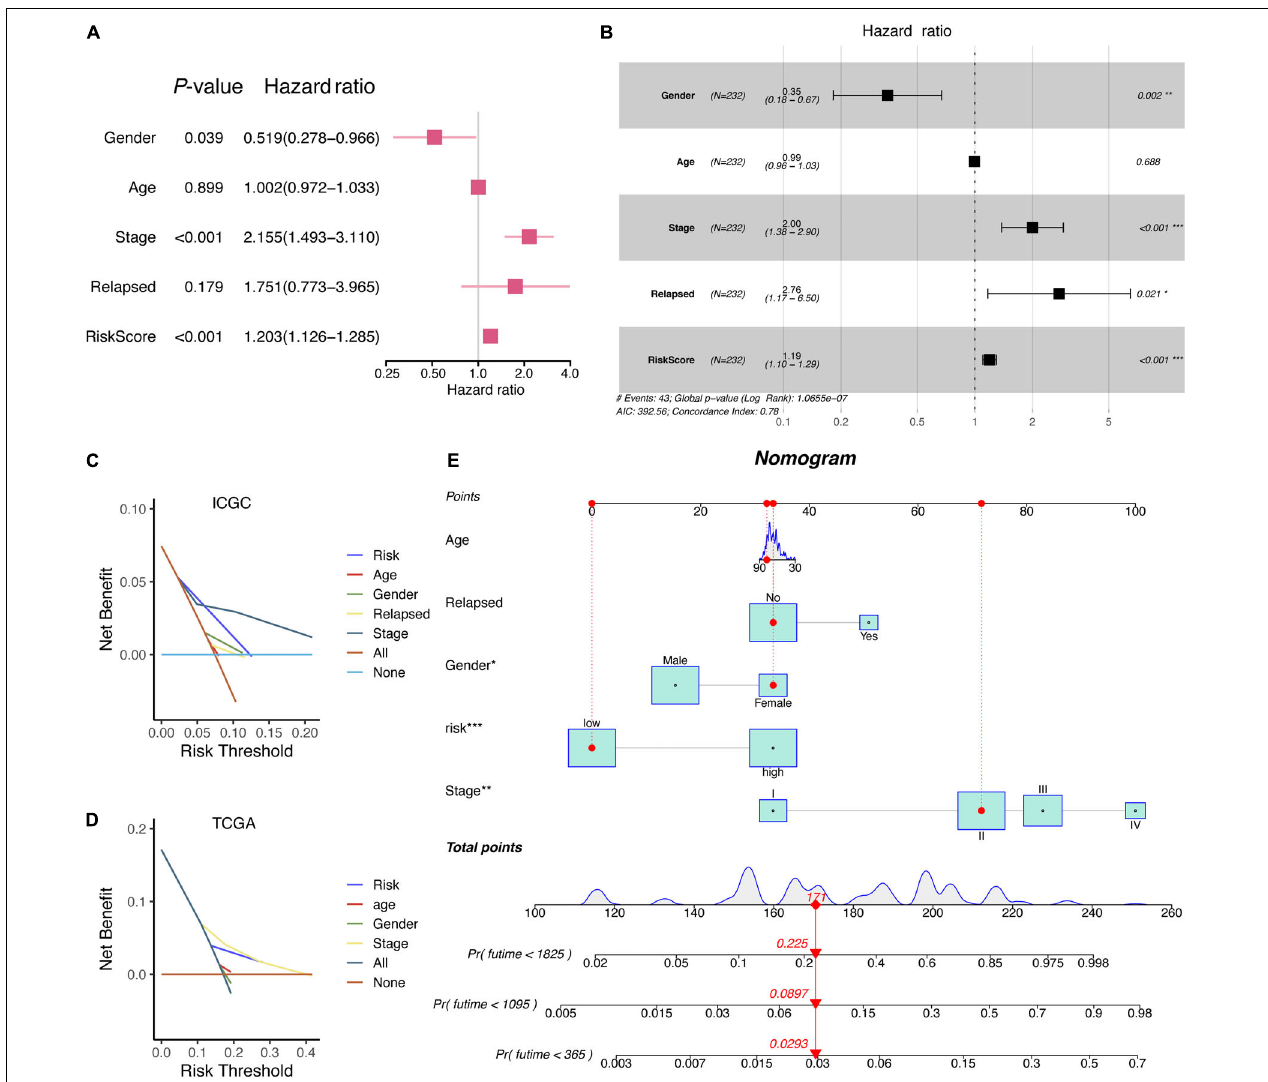
FIGURE 8 | The corresponding nomogram developed from the RiskScore signature and clinical characteristics of HCC patients in ICGC. (A) Univariate Cox analysis of clinical information. (B) Multivariate Cox analysis of clinical information. (C) DCA results of RiskScore signature and clinical characteristics in the ICGC database. (D) DCA results of RiskScore signature and clinical characteristics in the TCGA database. (E) A nomogram based on RiskScore signature and related clinical